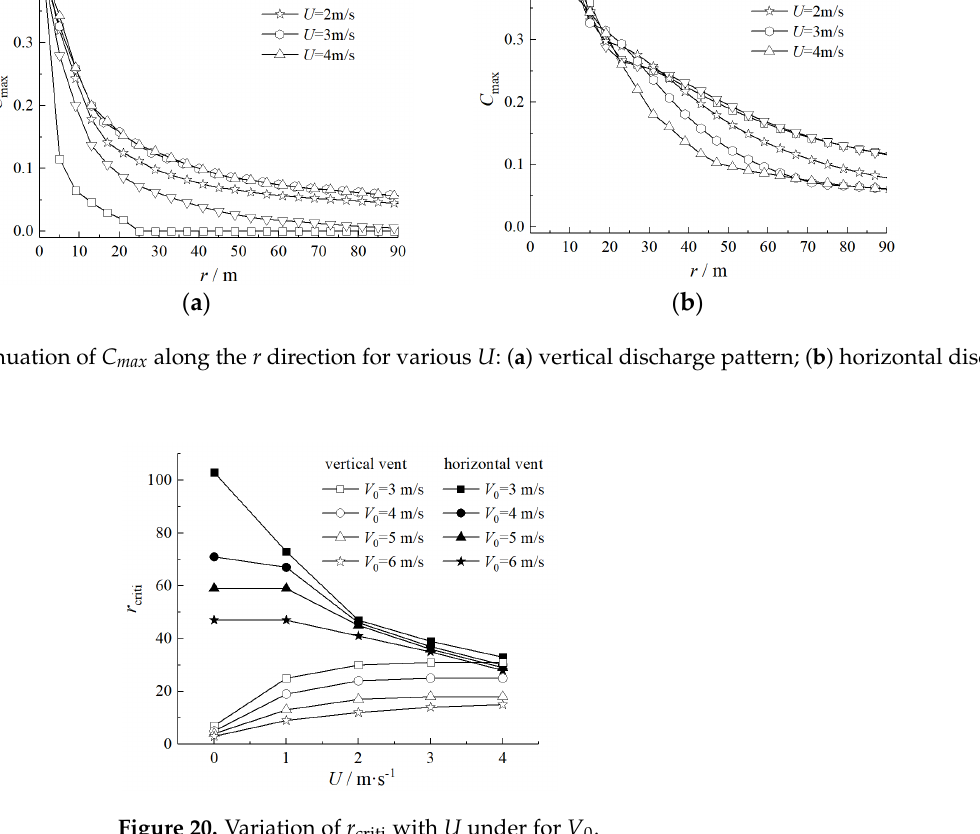
Figure 20. Variation of r criti with U under for V 0 .